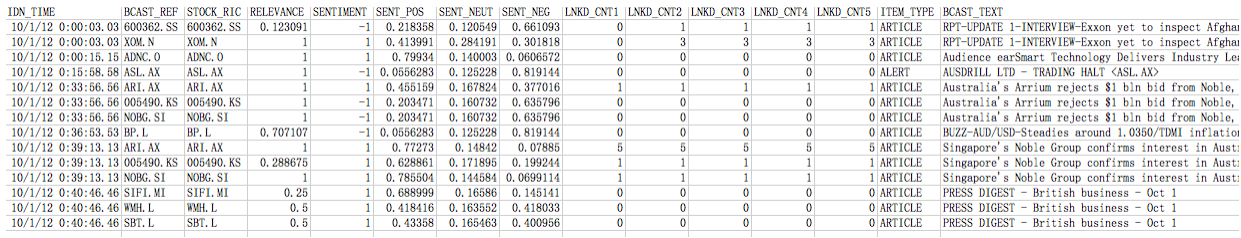
Figure 1. A snapshot of the news sentiment